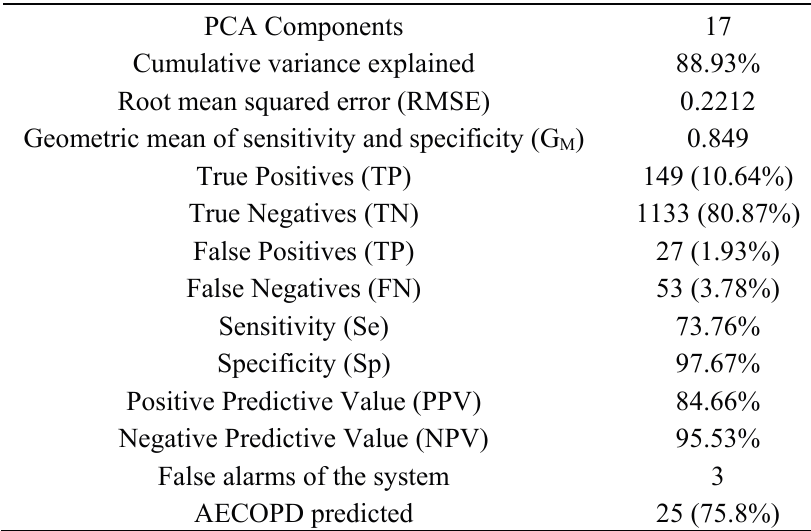
Figure 6. Interval of a respiratory signal and its spectrogram. The recording was remotely sent by a patient seven days prior to medical care (prodromal phase). Table 3. Classifier performance evaluation for the evaluated PCA-SVM